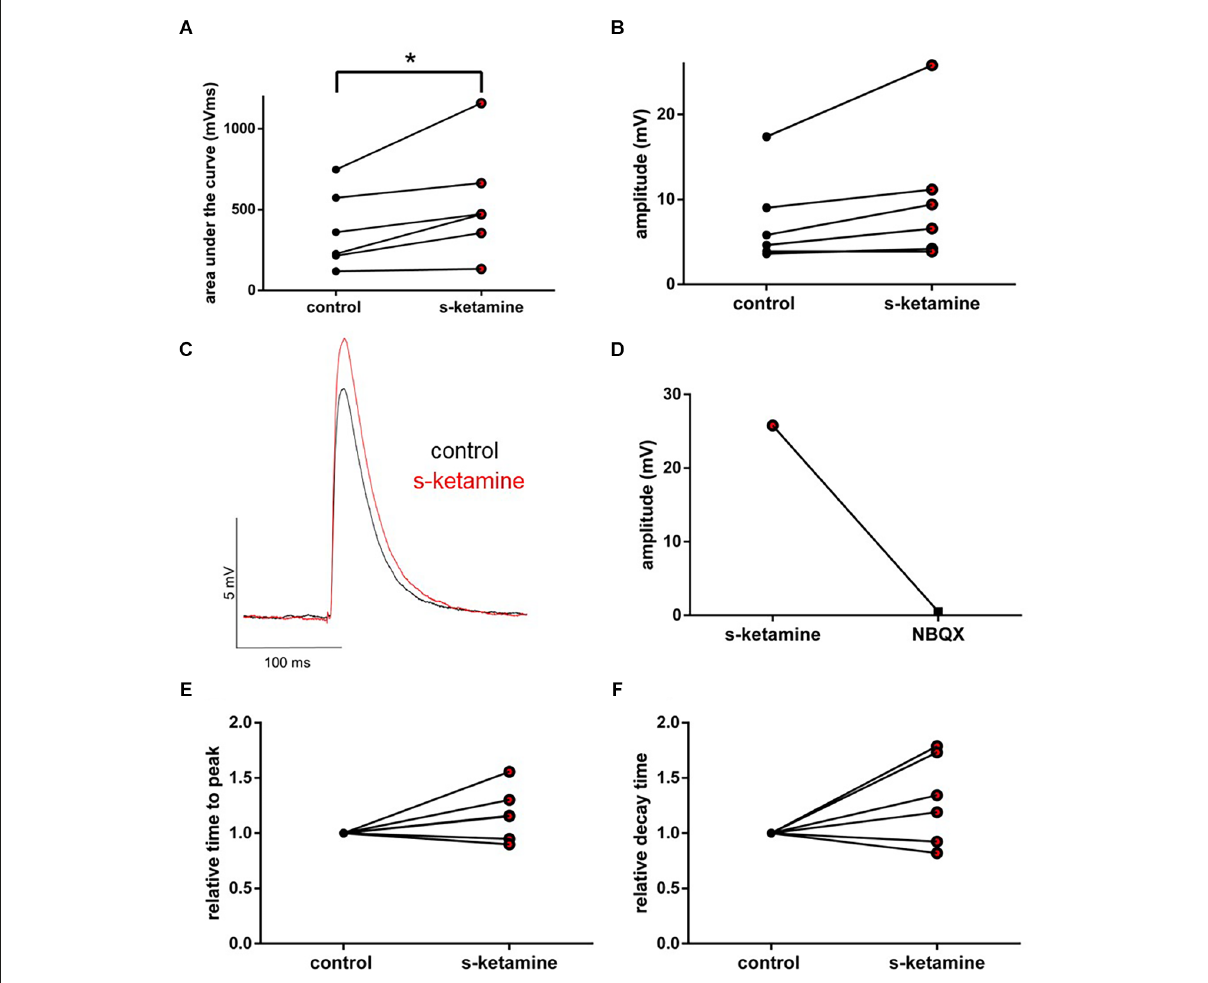
FIGURE8 s-ketamine caused an increase of the AUC (* p = 0.031) (A) and the amplitude ( p = 0.063) (B) of intracortical AMPA-receptor mediated eEPSPs. Cohen’s U3_1 displayed a large effect size for the AUC [1 (1 1)] and the amplitude [1 (0.5 1)]. (C) Representative traces. (D) Proof of concept: No eEPSPs after adding the AMPA-receptor antagonist NBQX. (E) s-ketamine led to no significant alteration of the relative time to peak (p = 0.156), nor to the relative decay time ( p = 0.156) (F)